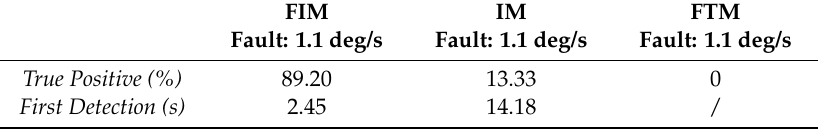
Table 7. Mean FD performance in the four validation flights for the sensor q (k).